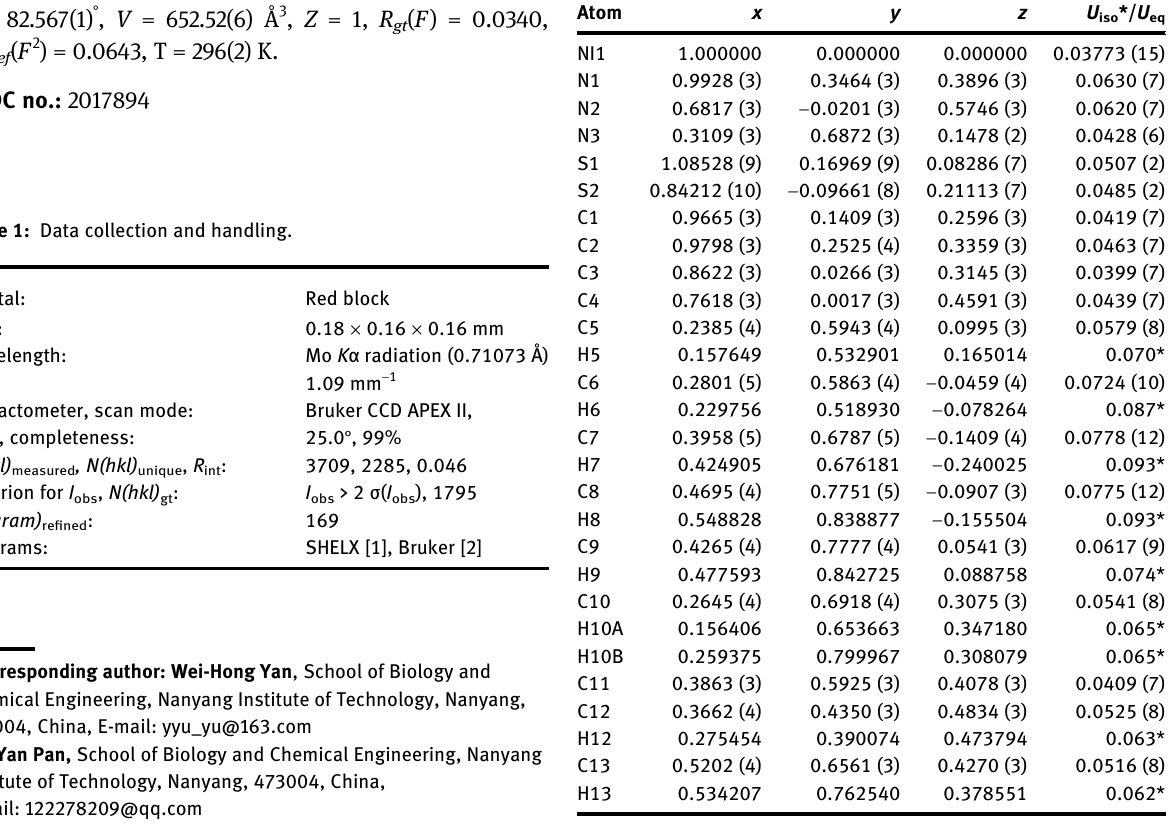
mercial sources and used without further purification. The